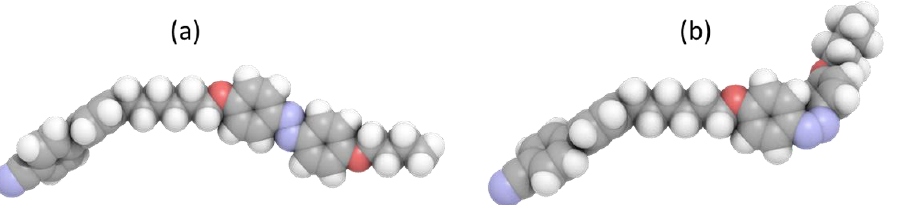
Figure 12. The shapes of the ( a ) trans and ( b ) cis isomers of